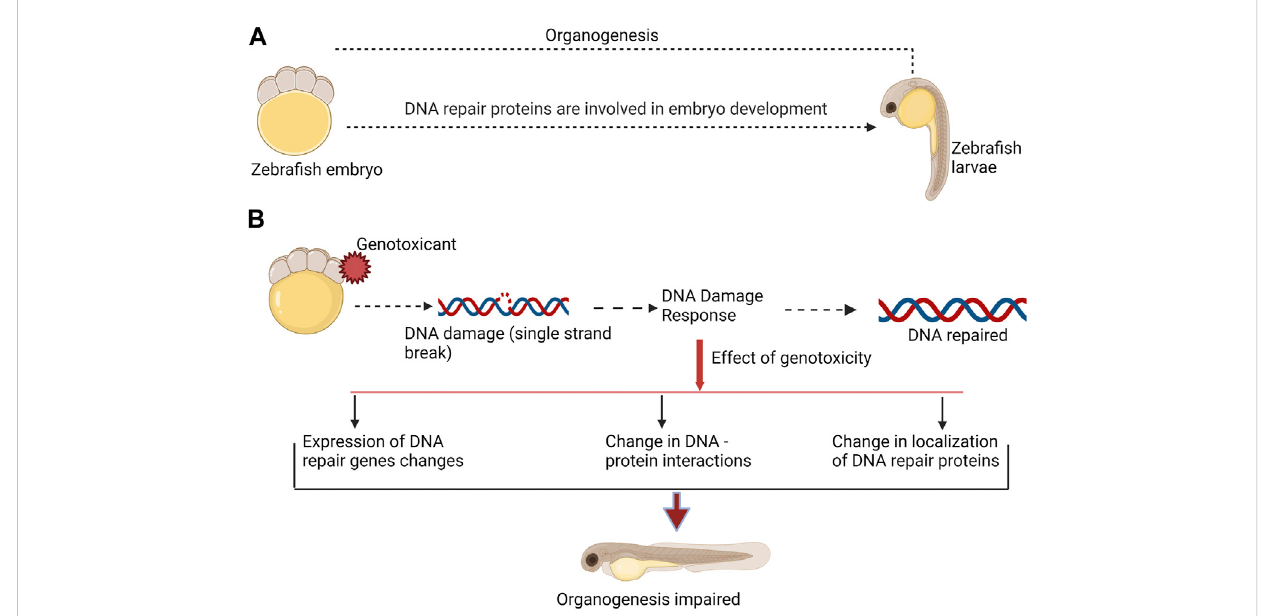
FIGURE 1 DNA repair proteins are involved in both, normal embryo development, and DNA damage response. (A) . During normal embryo development DNA repair proteins participate in organogenesis. (B) . Genotoxicant exposure at embryonic stage can impair normal organogenesis. Genotoxicants induce DNA damage, which requires activity of DNA repair proteins. DNA damage response include changes in expression of DNA repair genes and proteins, changes in DNA-protein interactions, and affect the localization of DNA repair proteins. Taken together, these alterations may affect function of DNA repair proteins in organogenesis. This can consequently result in